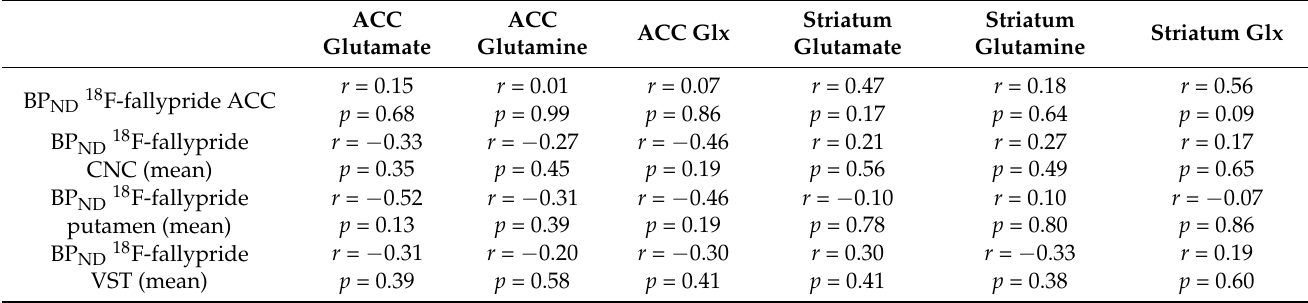
Table 2. Associations between dopaminergic and glutamatergic functioning in 22q11DS 1